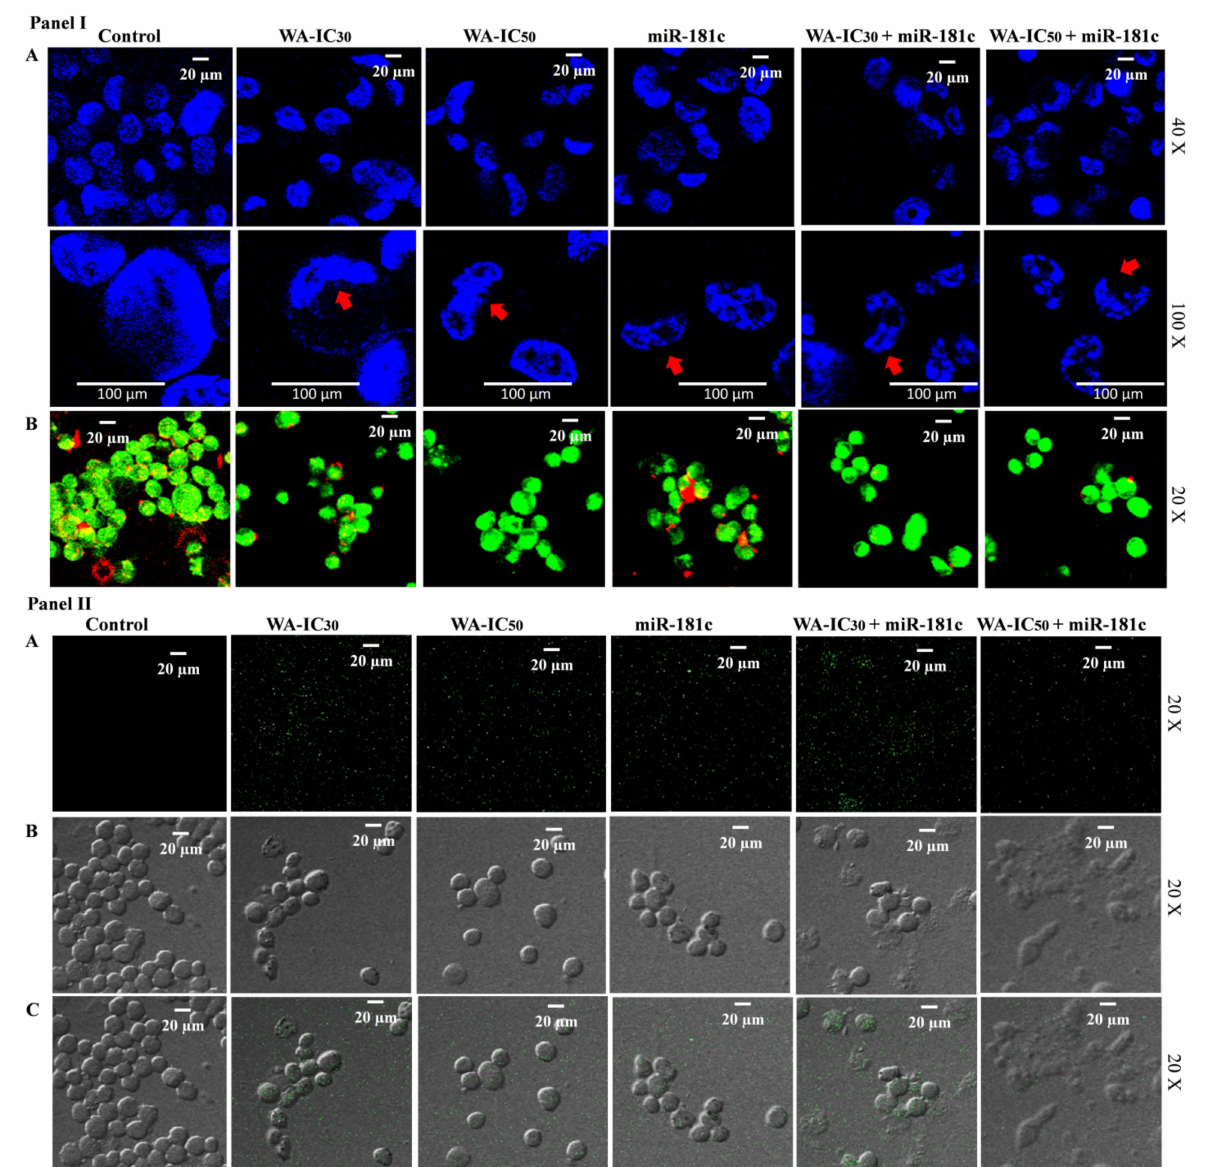
Figure 5. The effect of miR-181c-5p mimic and Withaferin A co-treatment on apoptosis-related morphological changes, mitochondrial membrane potential, and reactive oxygen species generation in triple-negative breast cancer cells. Panel I: ( A ) Effect of Withaferin A and miR-181c-5p alone and in co-treatment on apoptosis-related morphological changes in MDA-MB-231 cell viability in 24 h exposure. Panel I: ( B ) Effect of Withaferin A and miR-181c-5p alone and in co-treatment on mitochondrial membrane potential in MDA-MB-231 cell viability in 24 h exposure. Panel II: Effect of Withaferin A and miR-181c-5p alone and in co-treatment on reactive oxygen species generation in MDA-MB-231 cell viability in 24 h exposure. ( A – C ). The results were compared with the control (vehicle-treated)